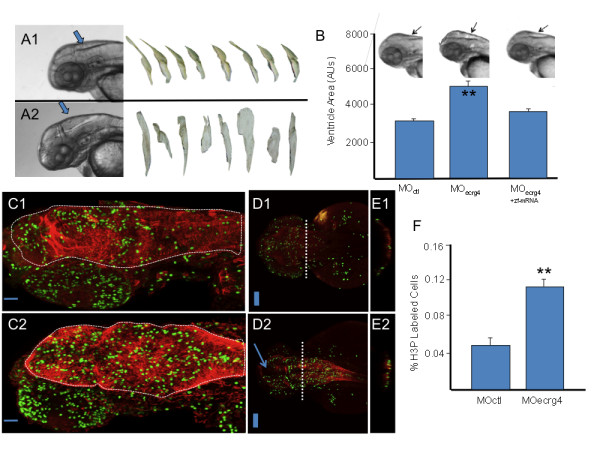
ECRG4 gene knockdown causes enlarged hindbrain ventricles and a hyper proliferative response in the developing zebrafish. A: Development of Zebrafish after morpholino injection 48 hours post fertilization. In control (A1) and Ecrg4 (A2) morpholino treatments, the head, eyes, heart, yolk and hind ventricle (arrows) were photographed for analysis. The anti-sense Ecrg4a morpholino caused readily detectable hindbrain ventriculomegaly resembling a hydrocephalus-edema-like response in the CNS. The ventricles can be isolated from images for analyses (n = 8). B: Quantification of developmental effects of morpholino injection. Hindbrain ventricle size was quantified by pixel area of microscope images from n = 8 control (MO ctl), n = 8 Ecrg4a MO-treated embryos or (n = 8) Ecrg4a MO co-injected with the Zebrafish mRNA ortholog A to neutralize specific inhibition (error bars: mean ± standard deviation). C-E: Cell growth in Zebrafish 24 hours after control or Ecrg4a morpholino injection 24 hours post fertilization. Proliferating cells in control MO (top panels) from sagittal (C1), dorsal (D1) or after cross sections at dashed line (E1) can be compared to similar sections of Ecrg4a MO (bottom panel) injected animals by staining for phosphorylated Histone 3 (H3P, green), a marker of cell growth. H3P-positive proliferating cells are compared to that of cytoplasmic glial fibrillary acidic protein (red). The arrow (D2) highlights space corresponding to enlarged ventricles in MO-Ecrg4 treated embryos. The H3P positive cells are on the ventricle surface and there are more H3P cells and thicker GFAP staining in Ecrg4a MO. Scale bar is 100 μm F Quantification of cell growth in Zebrafish after control or Ecrg4a morpholino injection. The amount of H3P-postive cell staining was determined as described in the text and compared between treatment groups (n = 7, mean ± SEM). There were significantly more labeled cells in the Ecrg4a morpholino group. Scale bar is 100 μm.